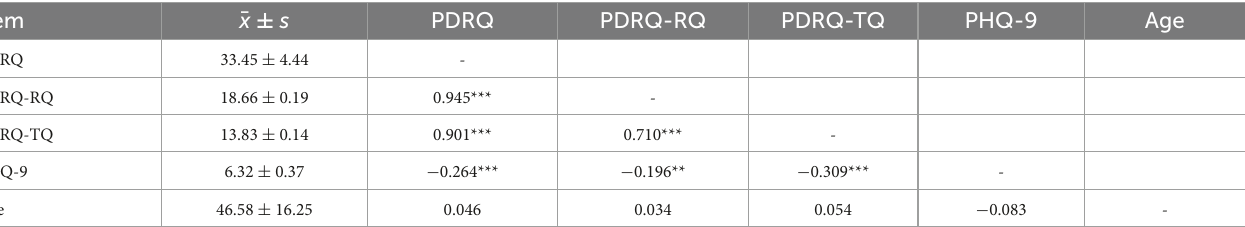
TABLE 3 Descriptive statistics and correlation coefficients between variables.